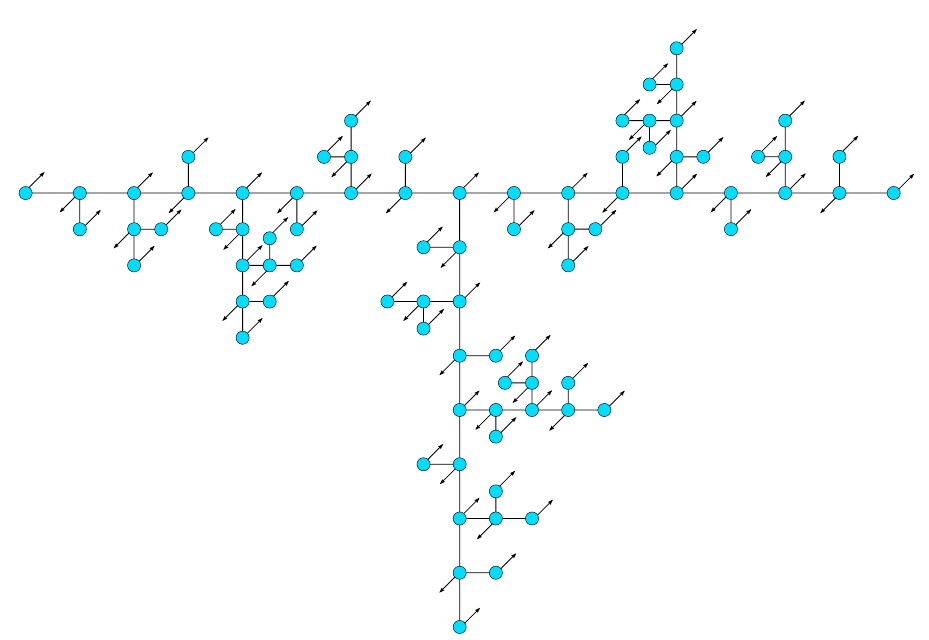
Figure 8. Schematic representation of the eigenmode corresponding to the largest eigenvalue of a G = 4 T-fractal. Version June 28, 2016 submitted to Polymers